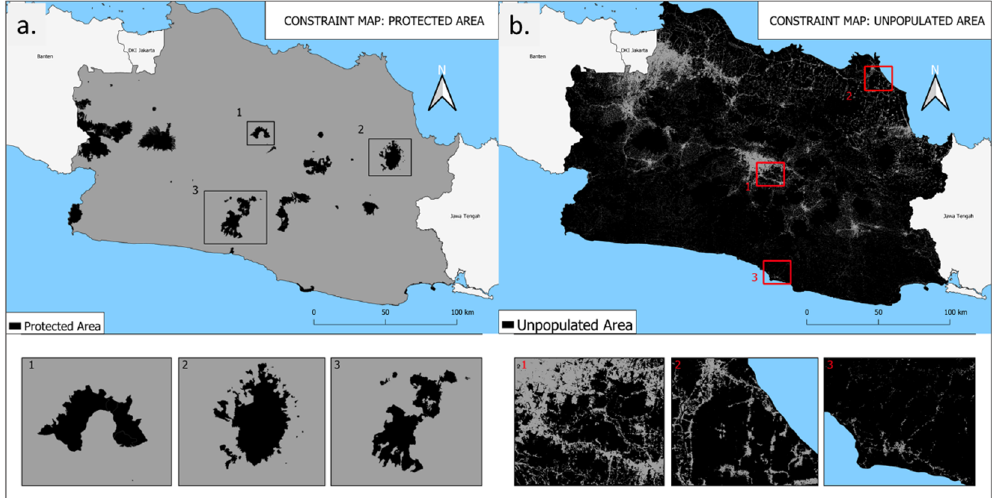
Figure 3. Constraints of: ( a ) protected areas and ( b ) unpopulated areas. Table 1. Summary of data types and sources.